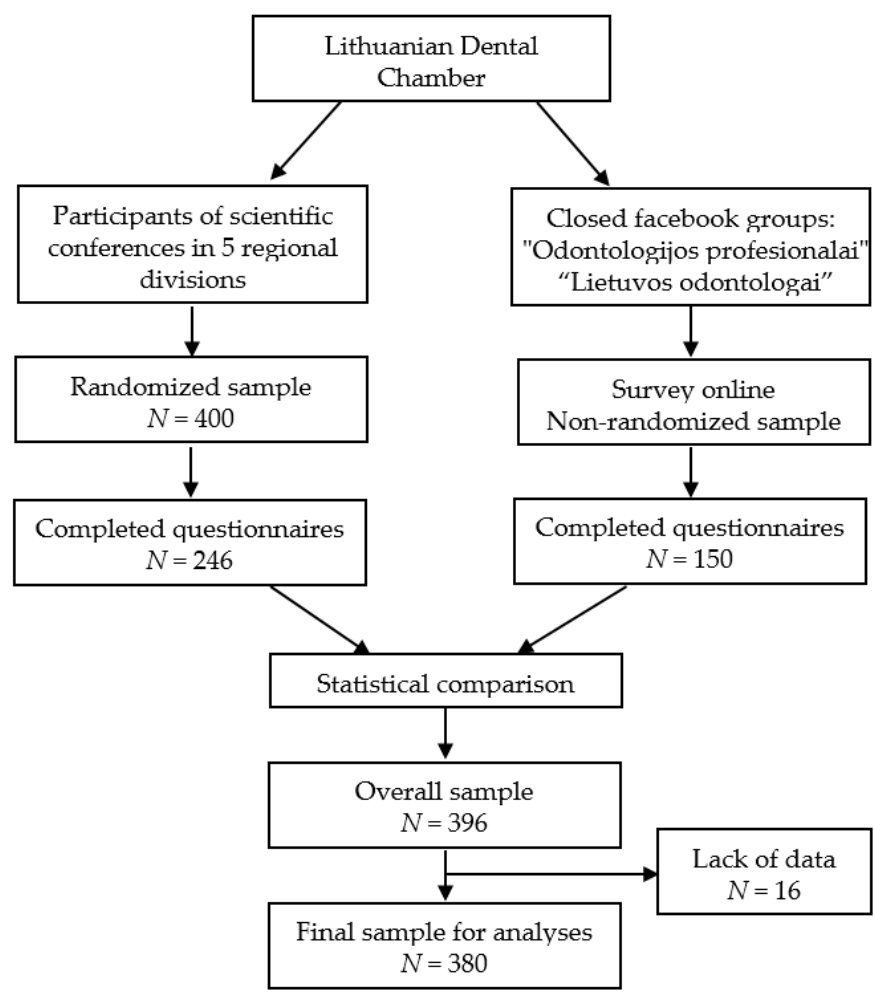
Figure 1. Flow chart of the data collection process.